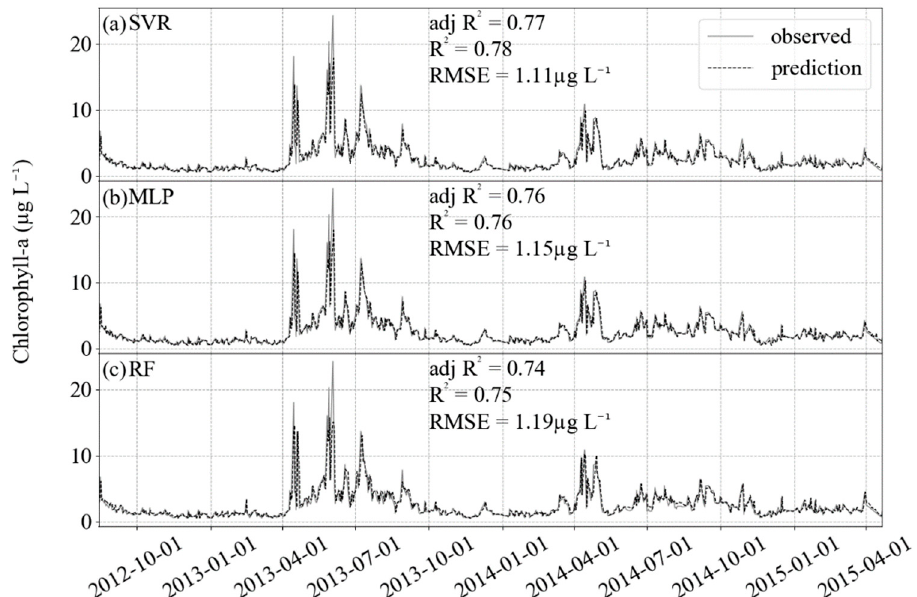
Figure 5. Results of prediction (black dashed) and comparison with the observed test dataset (gray solid). For the three algorithms, R 2 is higher than 0.7 and RMSE lower than 1.2 µg L − 1 . ( a ) SVR, ( b ) MLP and ( c ) RF.